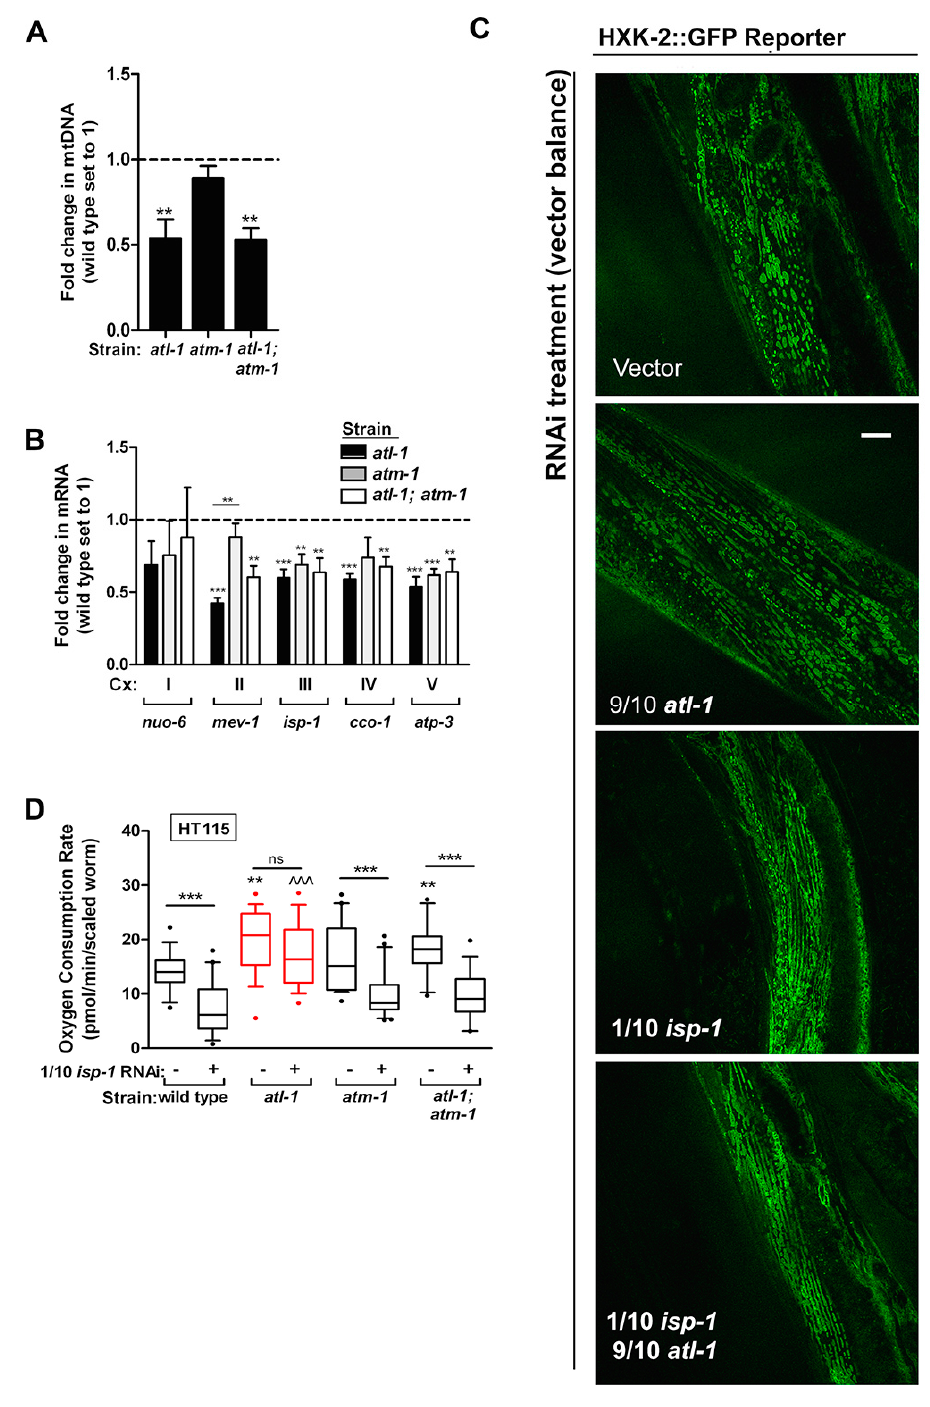
Figure 7. atl-1(tm853) mutants maintain normal oxygen consumption when confronted with disruption of their mitochondrial ETC. ( A ) Mitochondrial DNA abundance is significantly decreased in atl-1(tm853) mutants compared to wild type worms ( n = 3). ( B ) Transcript abundance of nuclear- encoded ETC genes is significantly decreased in atl-1(tm853) mutants relative to wild type worms ( n = 3; Cx: complex). ( C ) Morphology of body-wall muscle mitochondria assessed using HXK-2::GFP [63], following atl-1 knockdown in the absence or presence of mitochondrial ETC disruption (1/10th strength isp-1 RNAi). Both atl-1 and isp-1 knockdown significantly alter mitochondrial morphology relative to vector-control ( p < 0.0024, refer to Methods for significance testing). Scale bar: 20 microns. ( D ) atl-1(tm853) mutants are resistant to changes in oxygen consumption following isp-1 knockdown